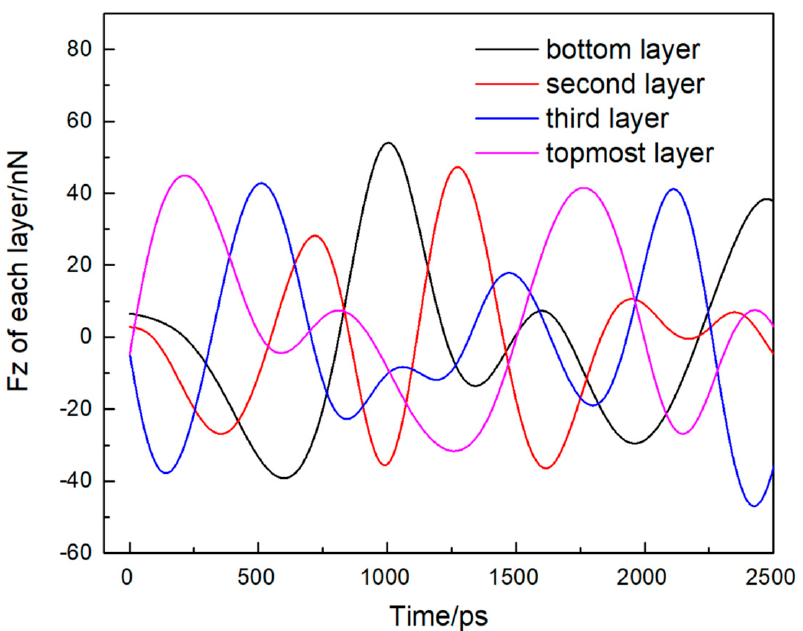
Figure 5. Fz to exfoliate each layer varying with time in four-layer graphene system, when the vertical upward velocity was 0.9 Å/ps.